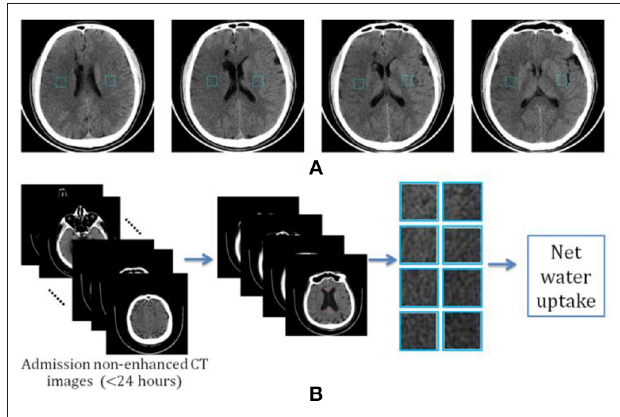
FIGURE 1 | Determination of image patch-based net water uptake (IP-NWU). (A) The standard reference images with patches of 30 × 30; (B) The procedure for calculating